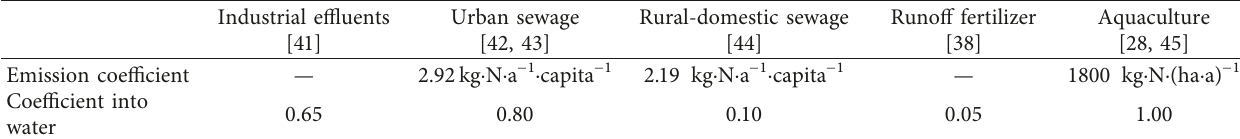
Figure 1: Location and administrative divisions of the Taihu watershed. Table 1: Coefficients of various pollutants produced and discharged into rivers.